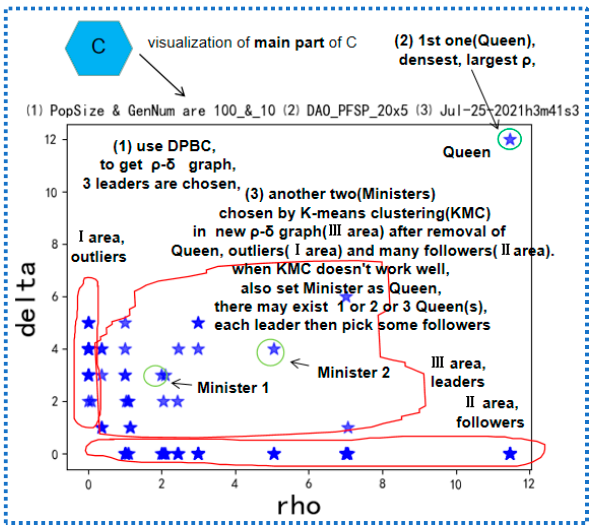
Figure 4. The details of complex operator C [5] can be seen above, which involves a clustering method. The stars means solutions. You can see a typical ρ - δ (rho-delta) graph in the simulation. ρ denotes local density, and δ denotes the minimum measured distance between one sample point and any other sample point that has higher density [49]. We will choose possible Queen and Ministers in the ρ - δ graph.